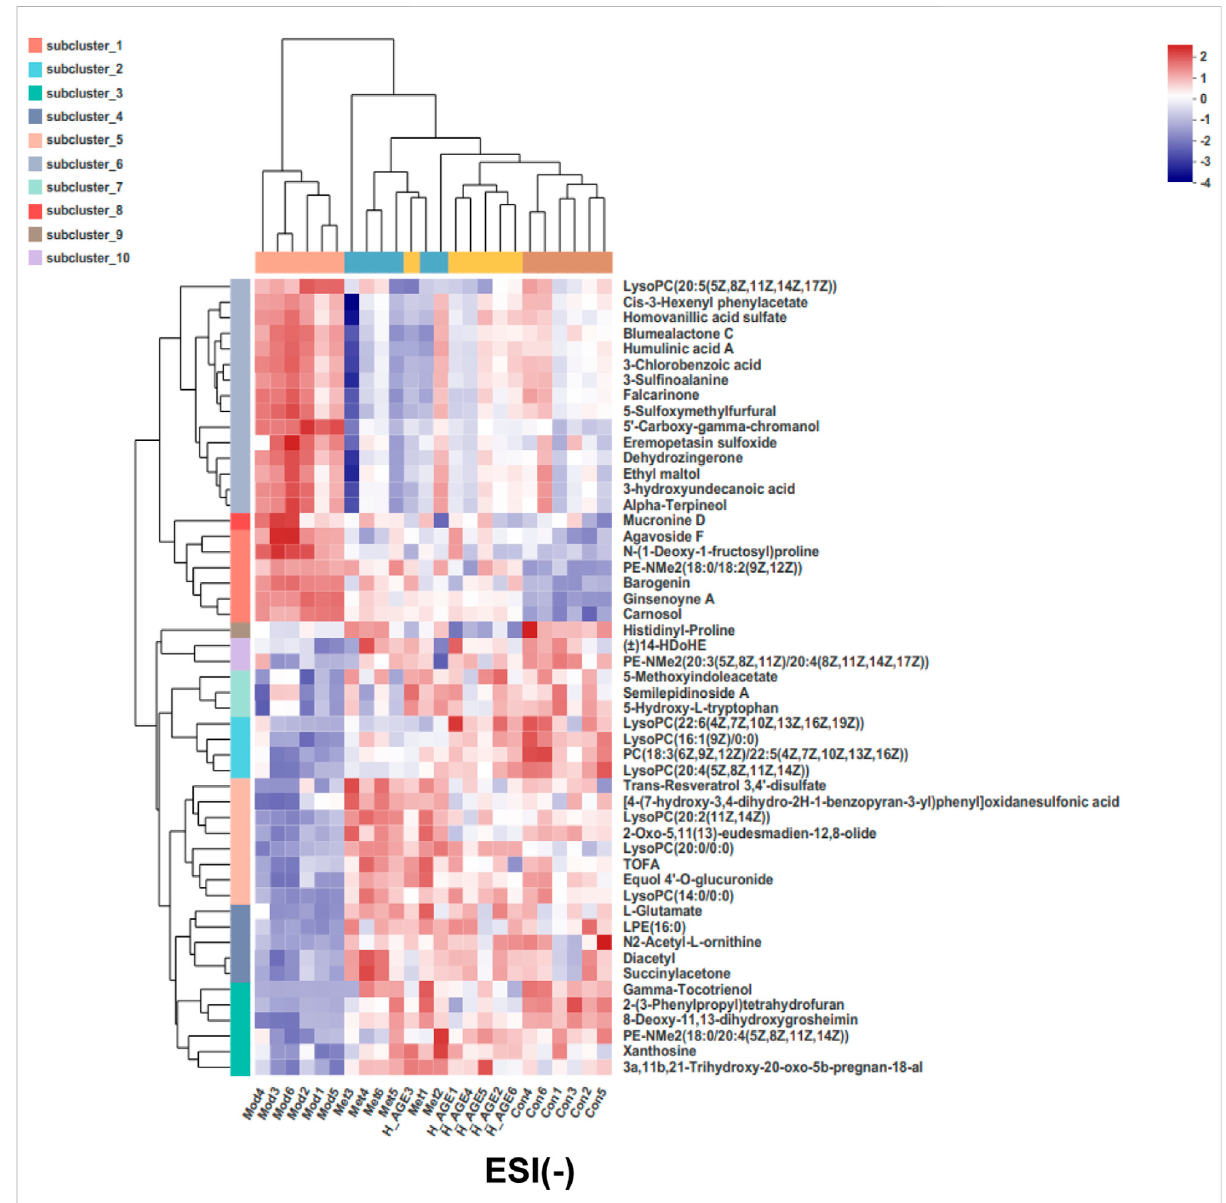
FIGURE 6 Heatmap of potential biomarkers. Rows: biomarkers; columns: samples. The shade in this picture depicts the relative expression size of metabolites in each group sample. Red depicts that the expression of biomarker was increased, blue depicts that the expression of biomarker was decreased (Mod vs. Con; Met vs. Mod; H_AGE vs.